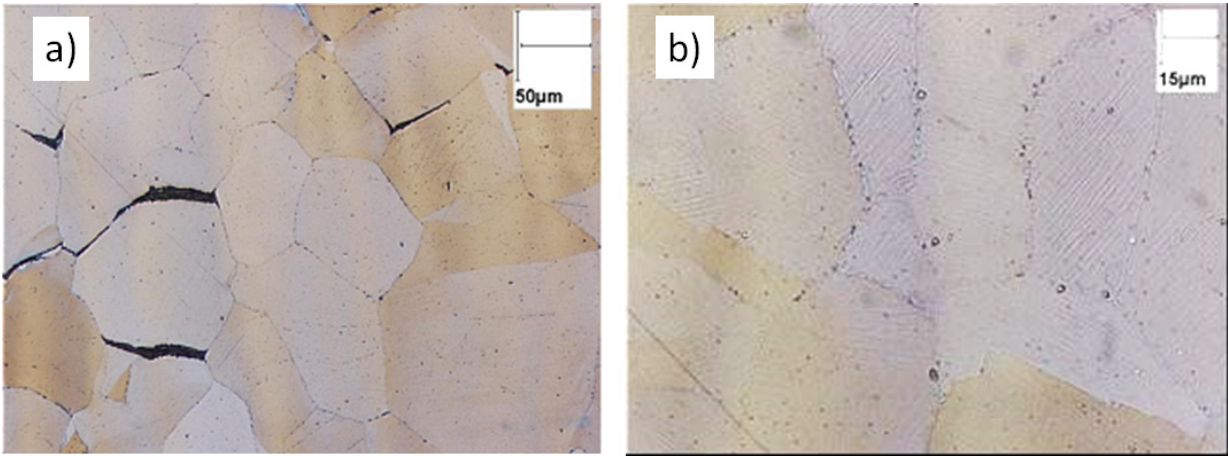
Figure 8. Hot ductility curves for selected solution-treated (solid lines) and as-cast (dashed lines) alloys.